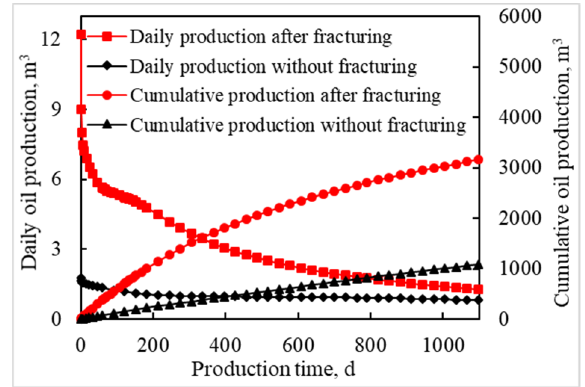
Figure 9. Production of well W1 with and without fracturing.